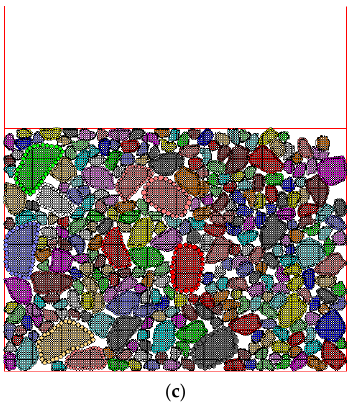
Figure 8. Modeling procedure of the virtual specimens: ( a ) first step of generation; ( b ) second step of generation; ( c ) third step of generation.